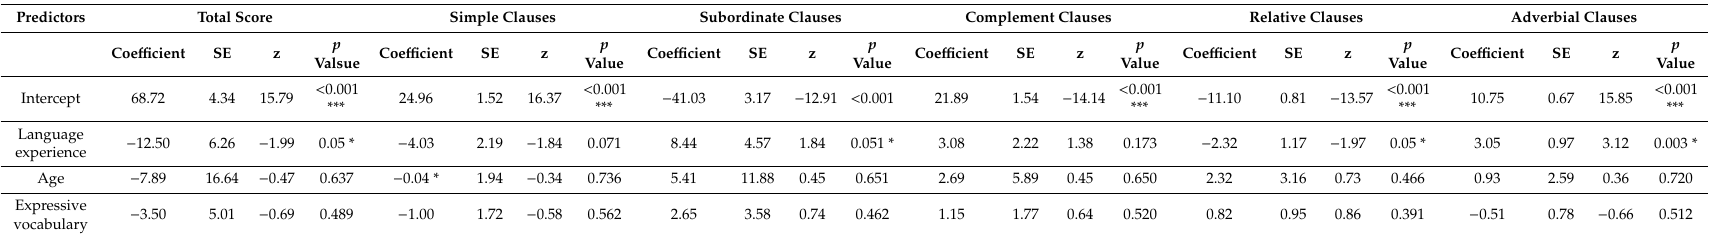
Table 5. Summary of logit mixed e ff ects models for accuracy in sentence repetition: Total scores, simple vs. subordinate clauses, and clause-types.